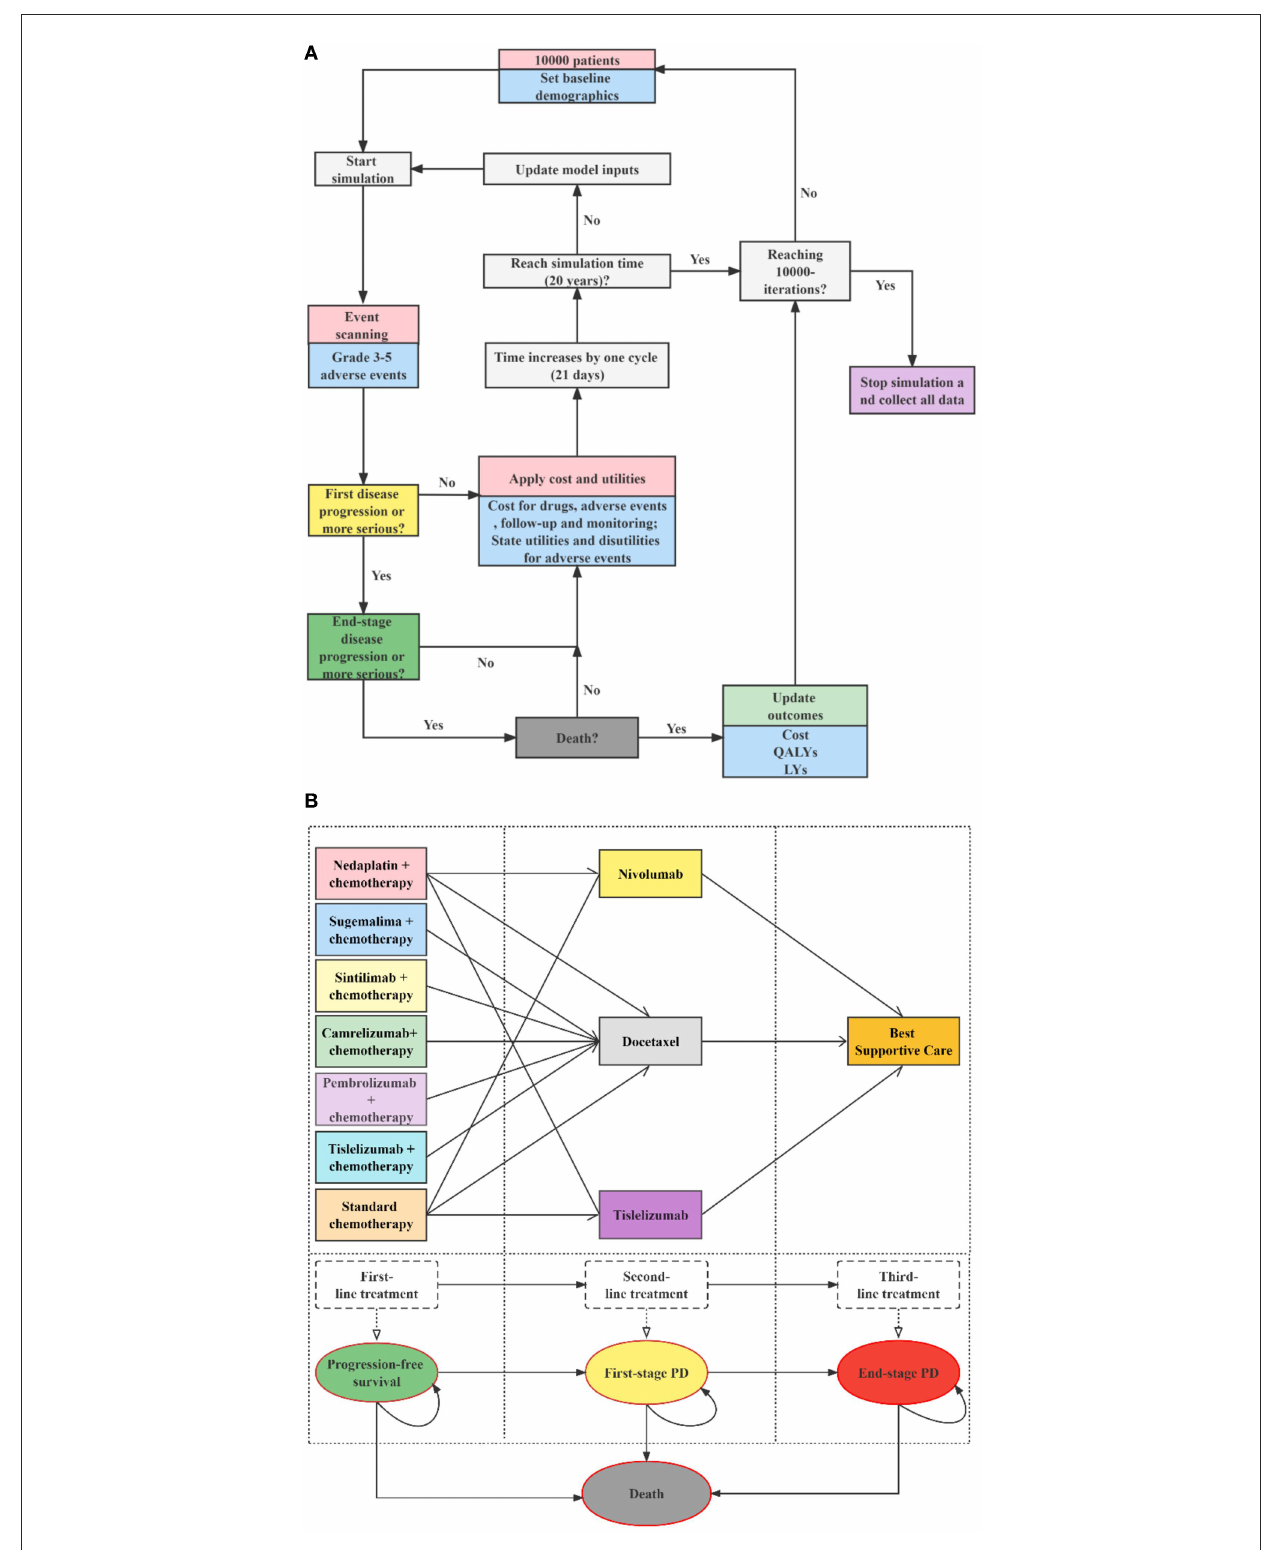
FIGURE1 Decision analytic model and treatment strategies. (A) Microsimulation model structure (above), (B) Multi-state survival model for treatment strategies (below), PD, progressive disease; LYs, life-years; QALYs, quality-adjusted life years.